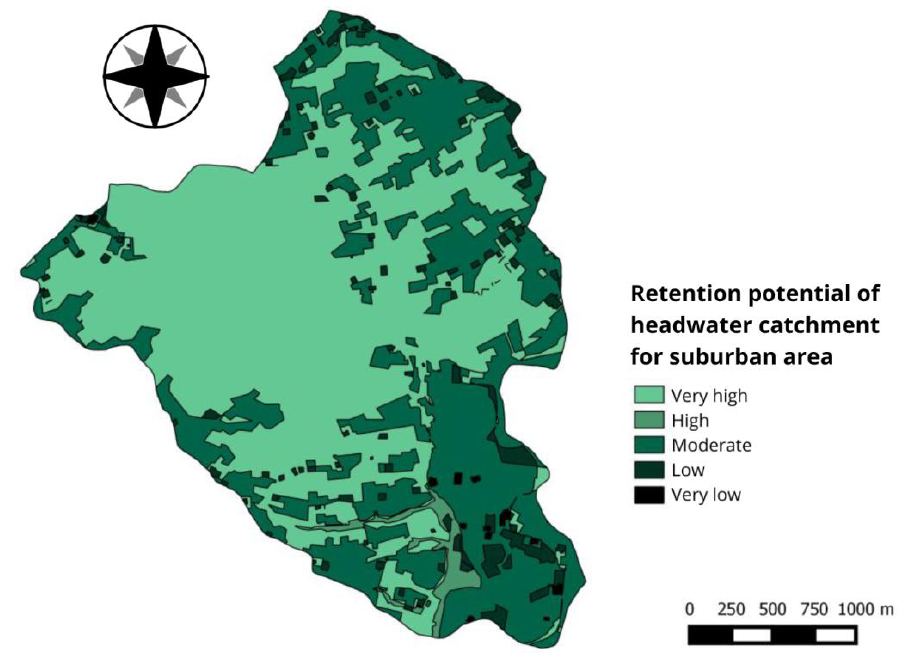
Water 2022 , 14 , x FOR PEER REVIEW Figure 10. Retention potential of headwater catchment for suburban area. Figure 10. Retention potential of headwater catchment for suburban area.